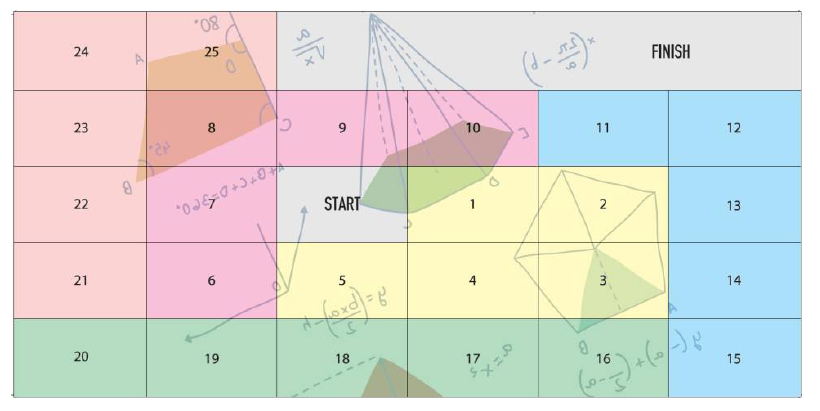
Figure 1. Dashboard.